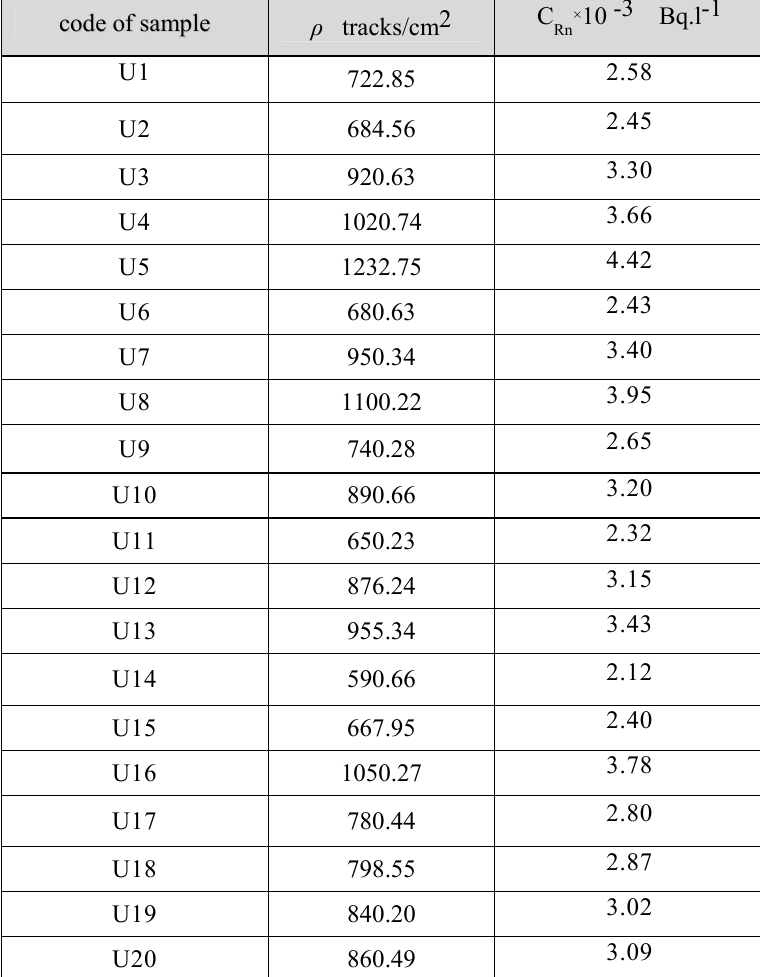
Table 2: Radon concentration of urine human